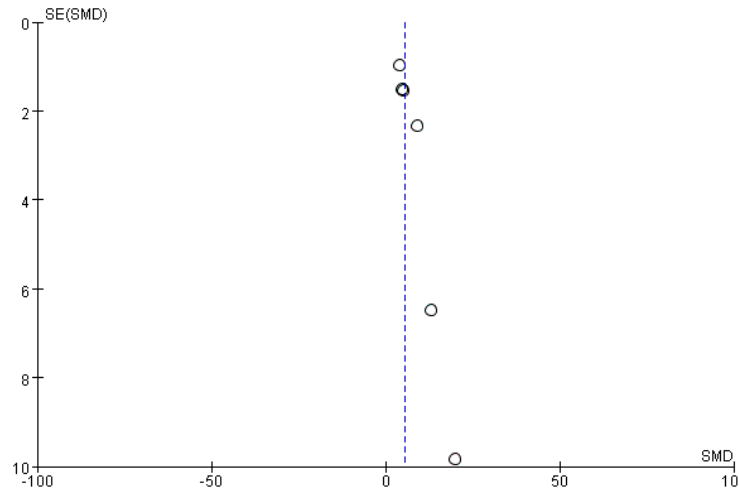
Figure 15. Funnel plot of studies assessment cancer treatment of S. crispa.